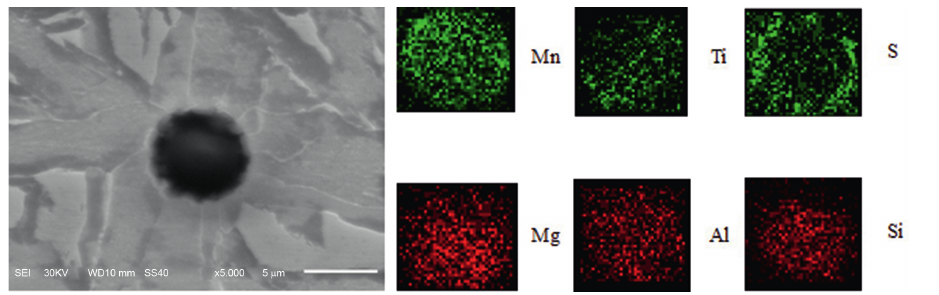
Figure 4: SEM micrographs and EDS mapping images of various elements for Ti-Mg-O inclusion in the etched sample.